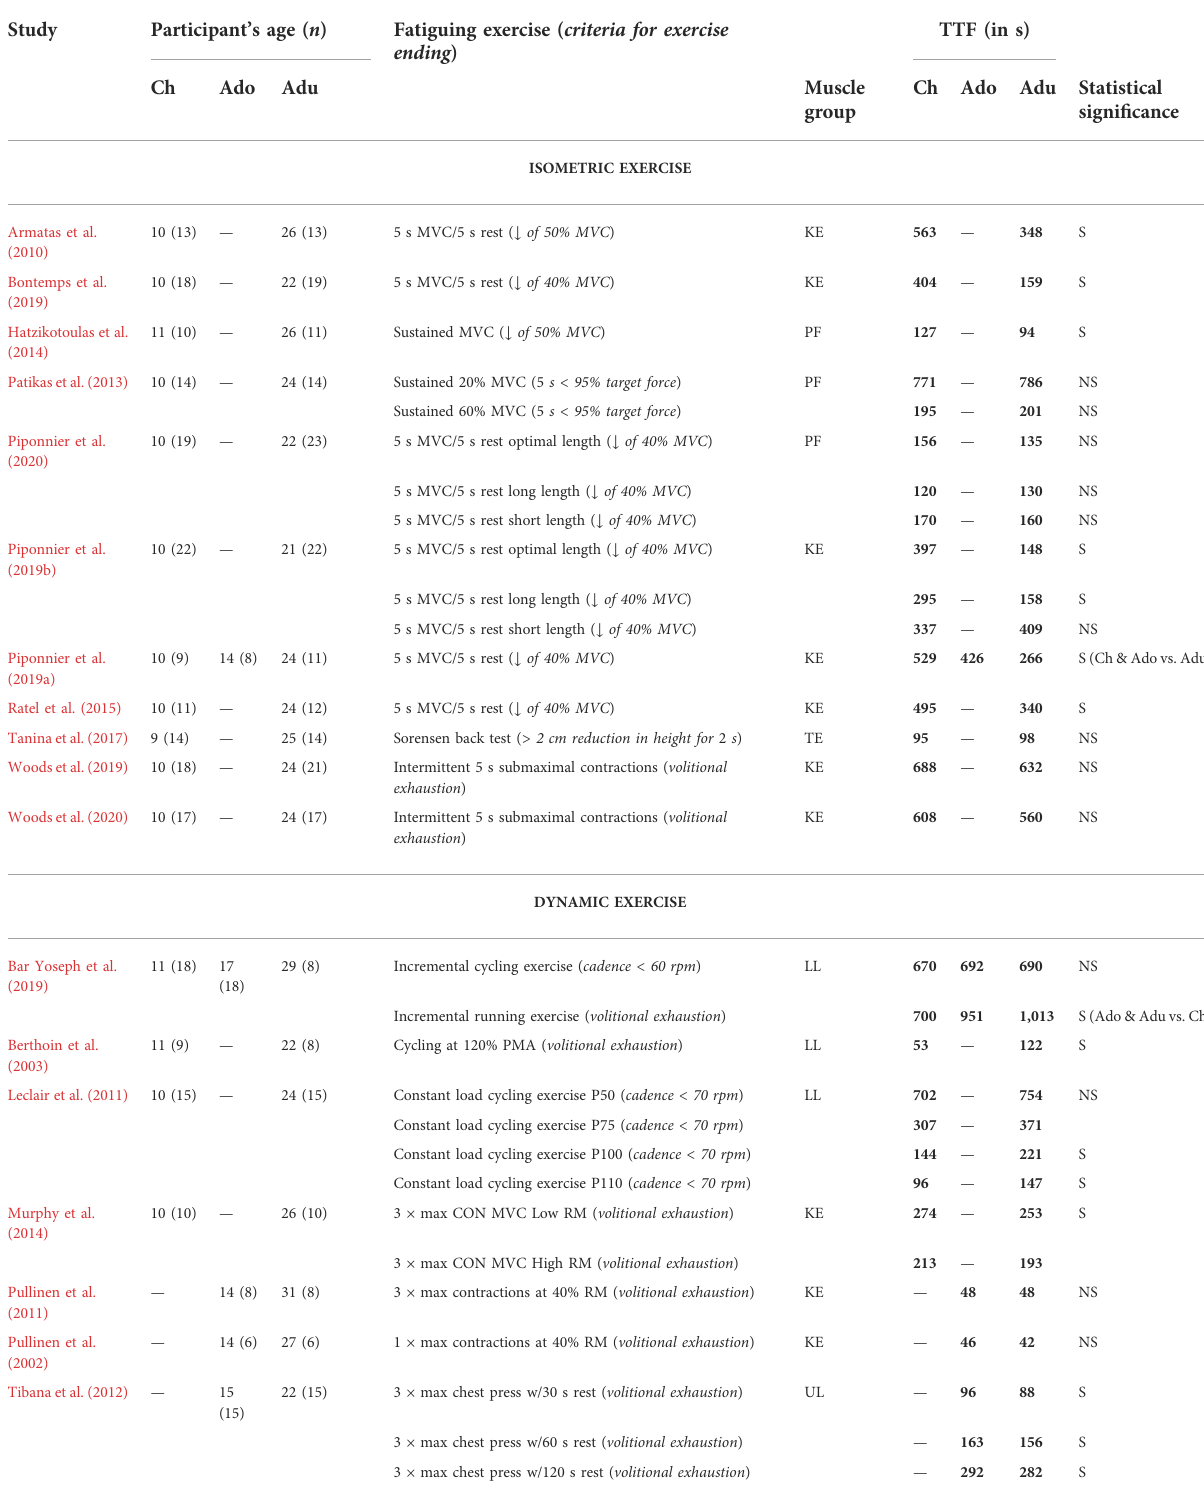
TABLE 2 Study characteristics — Time to task failure. Study Participant ’ s age ( n